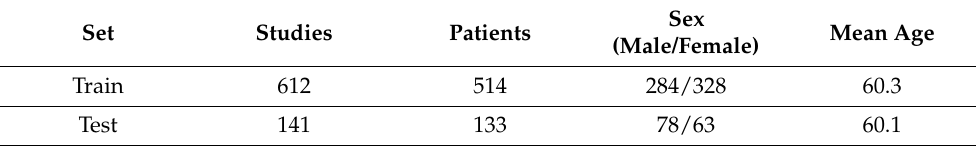
Table 2. Baseline characteristics of the Train and Test set.